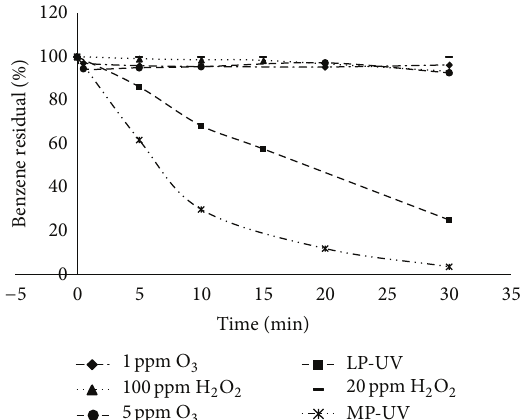
Figure 3: Removal of benzene using H 2 O 2 , O 3 , and UV alone. Figure 4: Removal of MTBE using UV/H 2 O 2 process.